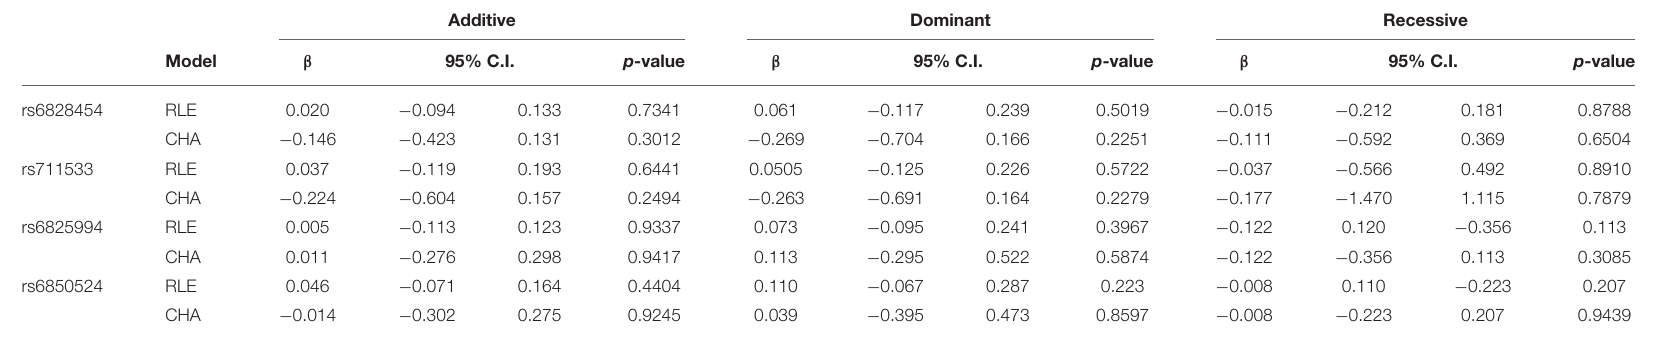
TABLE 3 | Main effects of CLOCK variants emerging as top SNPs in the interaction models on recent stressful life events and childhood adversities (rGE